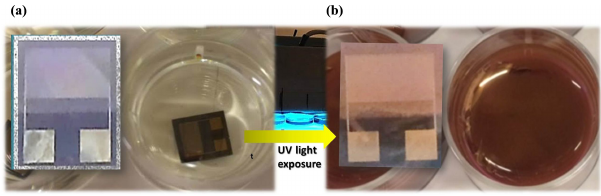
Figure 5. The chemosensor fabrication and final structure: IDE dipped (a) and exposed to UV light (b) for gold